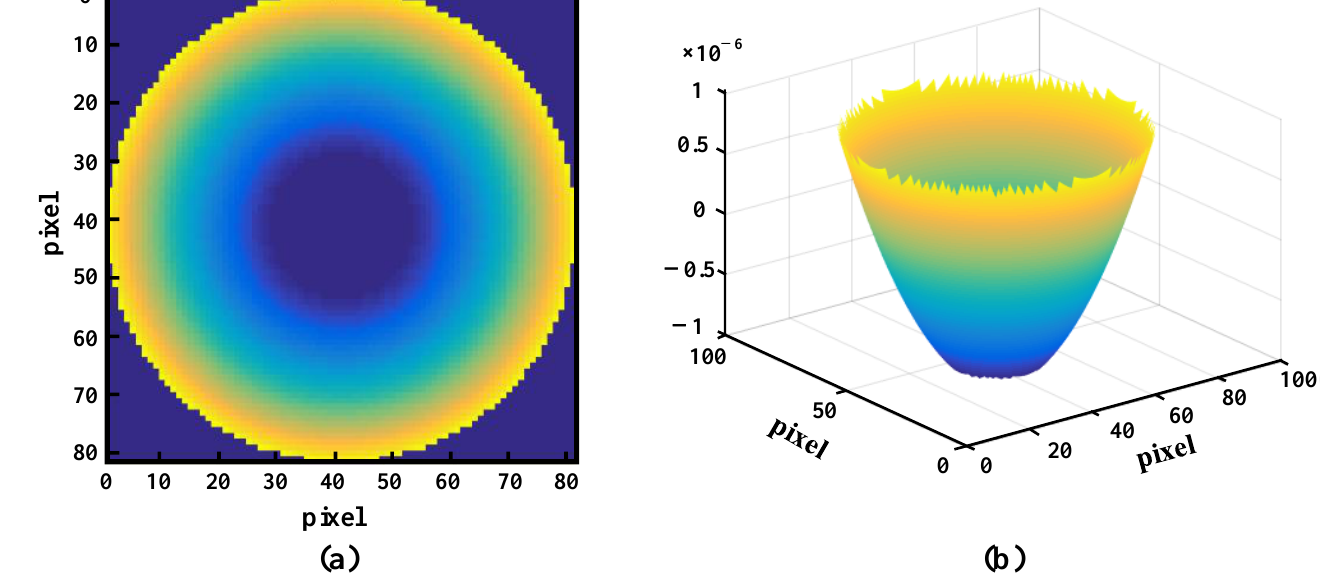
Figure 9. The statistical defocus aberration at the pupil of the 1.2 m telescope. ( a , b ).